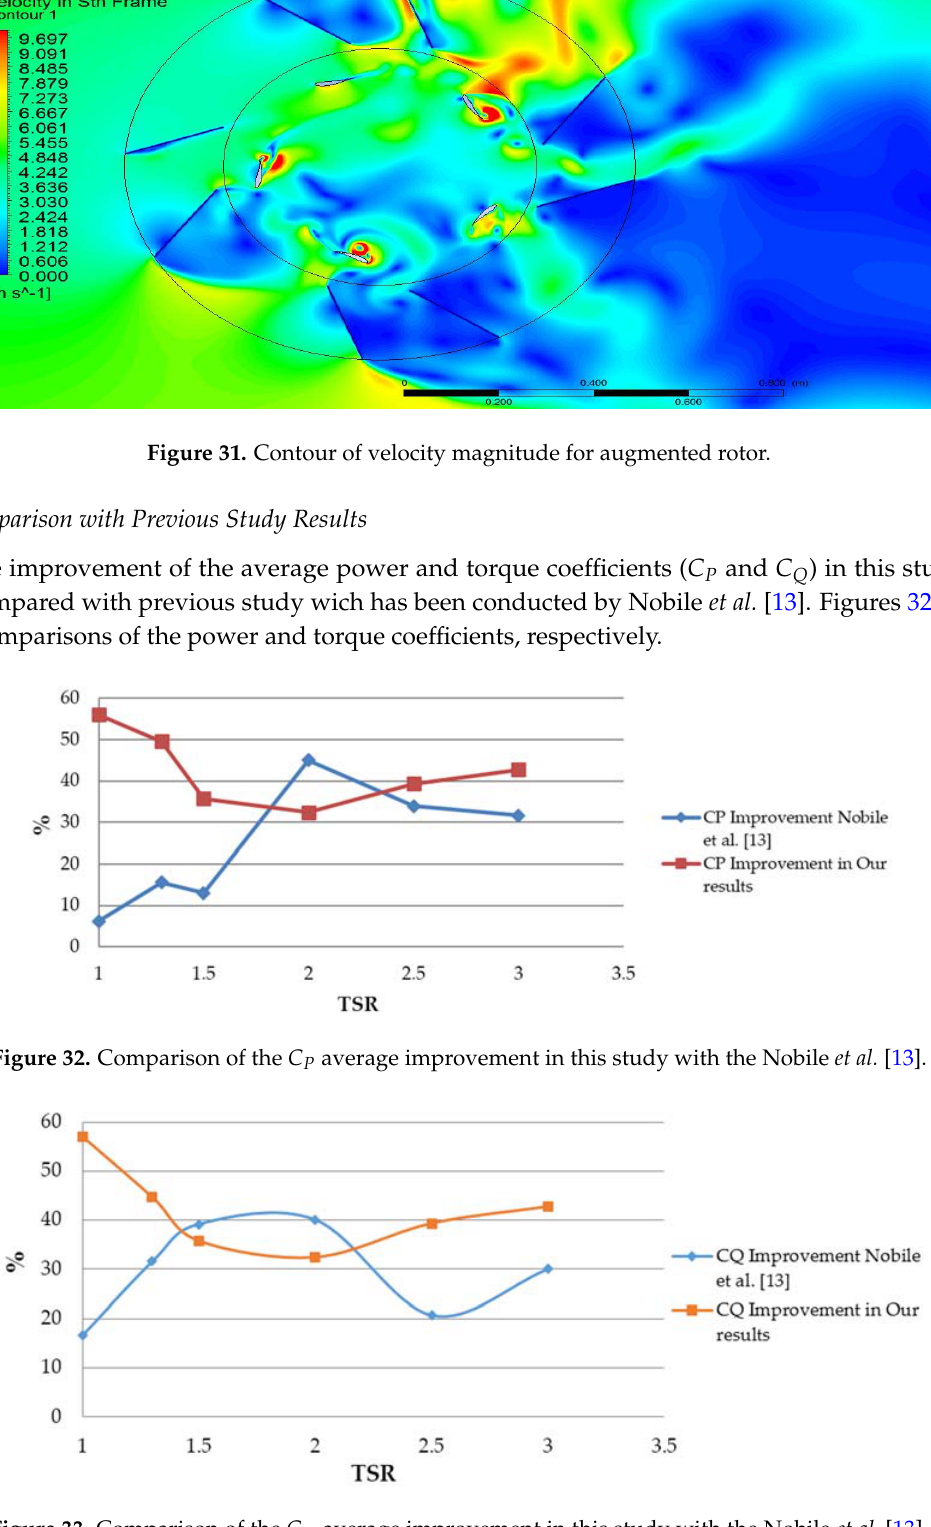
Figure 33. Comparison of the C Q average improvement in this study with the Nobile et al. [13].